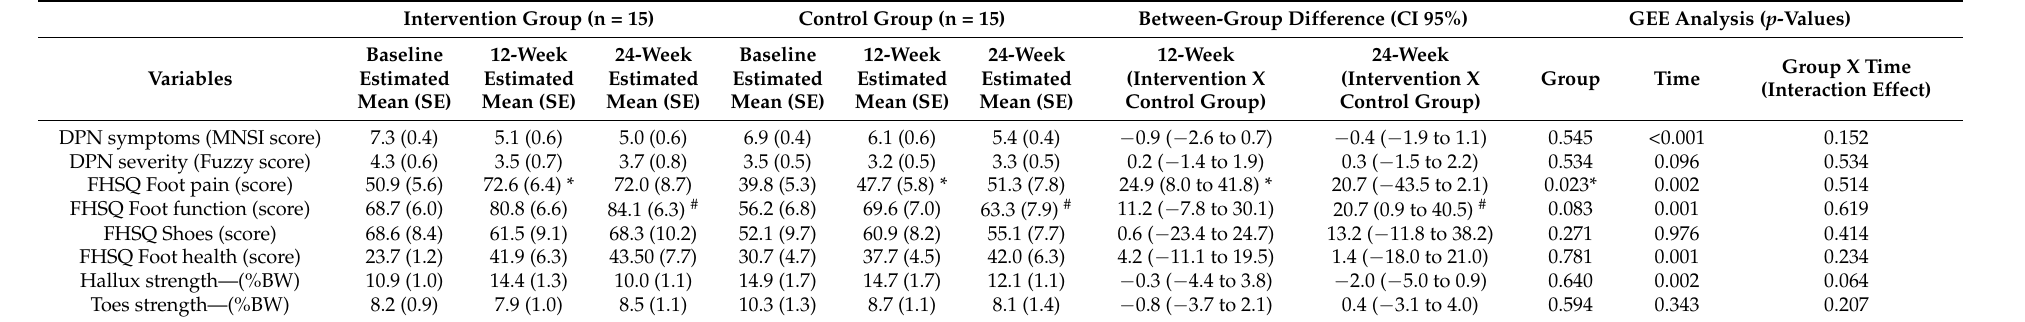
Table 2. Estimated mean (standard error; SE), p -values from Generalized Estimating Equation (GEE), and between-group mean differences at 12 and 24 weeks (95% confidence interval) of the clinical outcomes for the control and intervention groups.